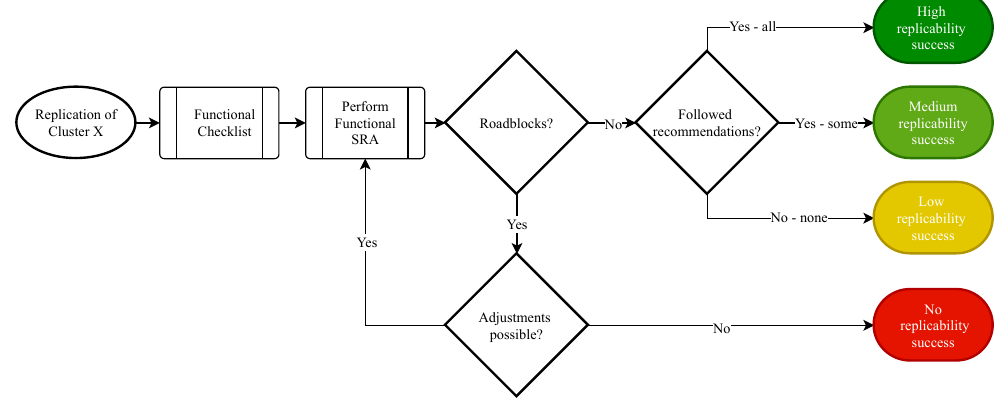
Figure 17. Functional-oriented replication paths identified.